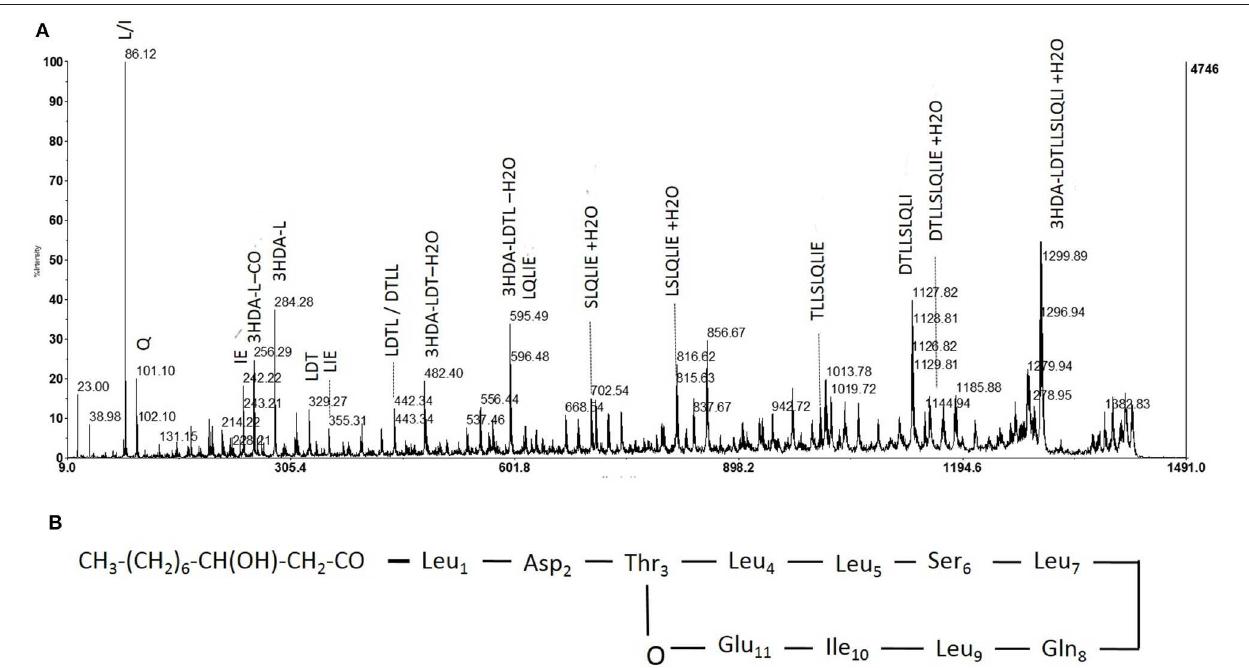
FIGURE 4 | Fragmentation pattern of lipopeptide m/z 1409 and proposed structure. (A) Product ions obtained by fragmentation using MALDI-TOF. (B) Determined structure of purified lipopeptide ( m/z 1409) based on mass spectrometric and NMR